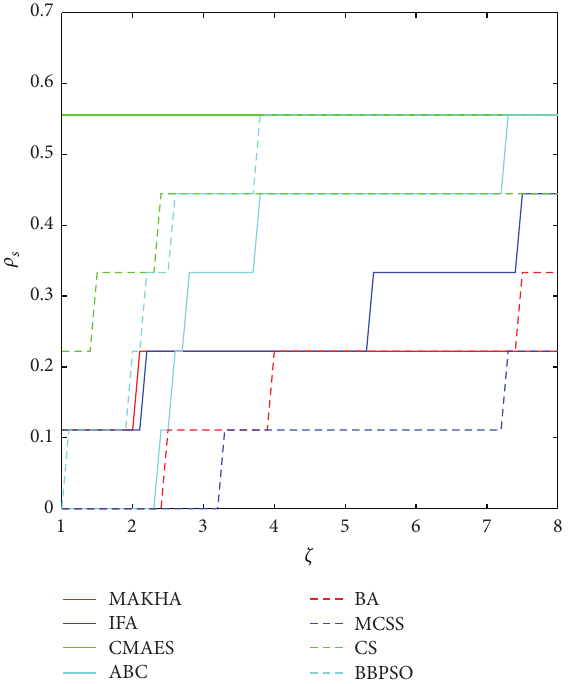
Figure 11: Performance profile (PP) of the efficiency metric of the eight metaheuristics for the 9 phase stability and equilibrium